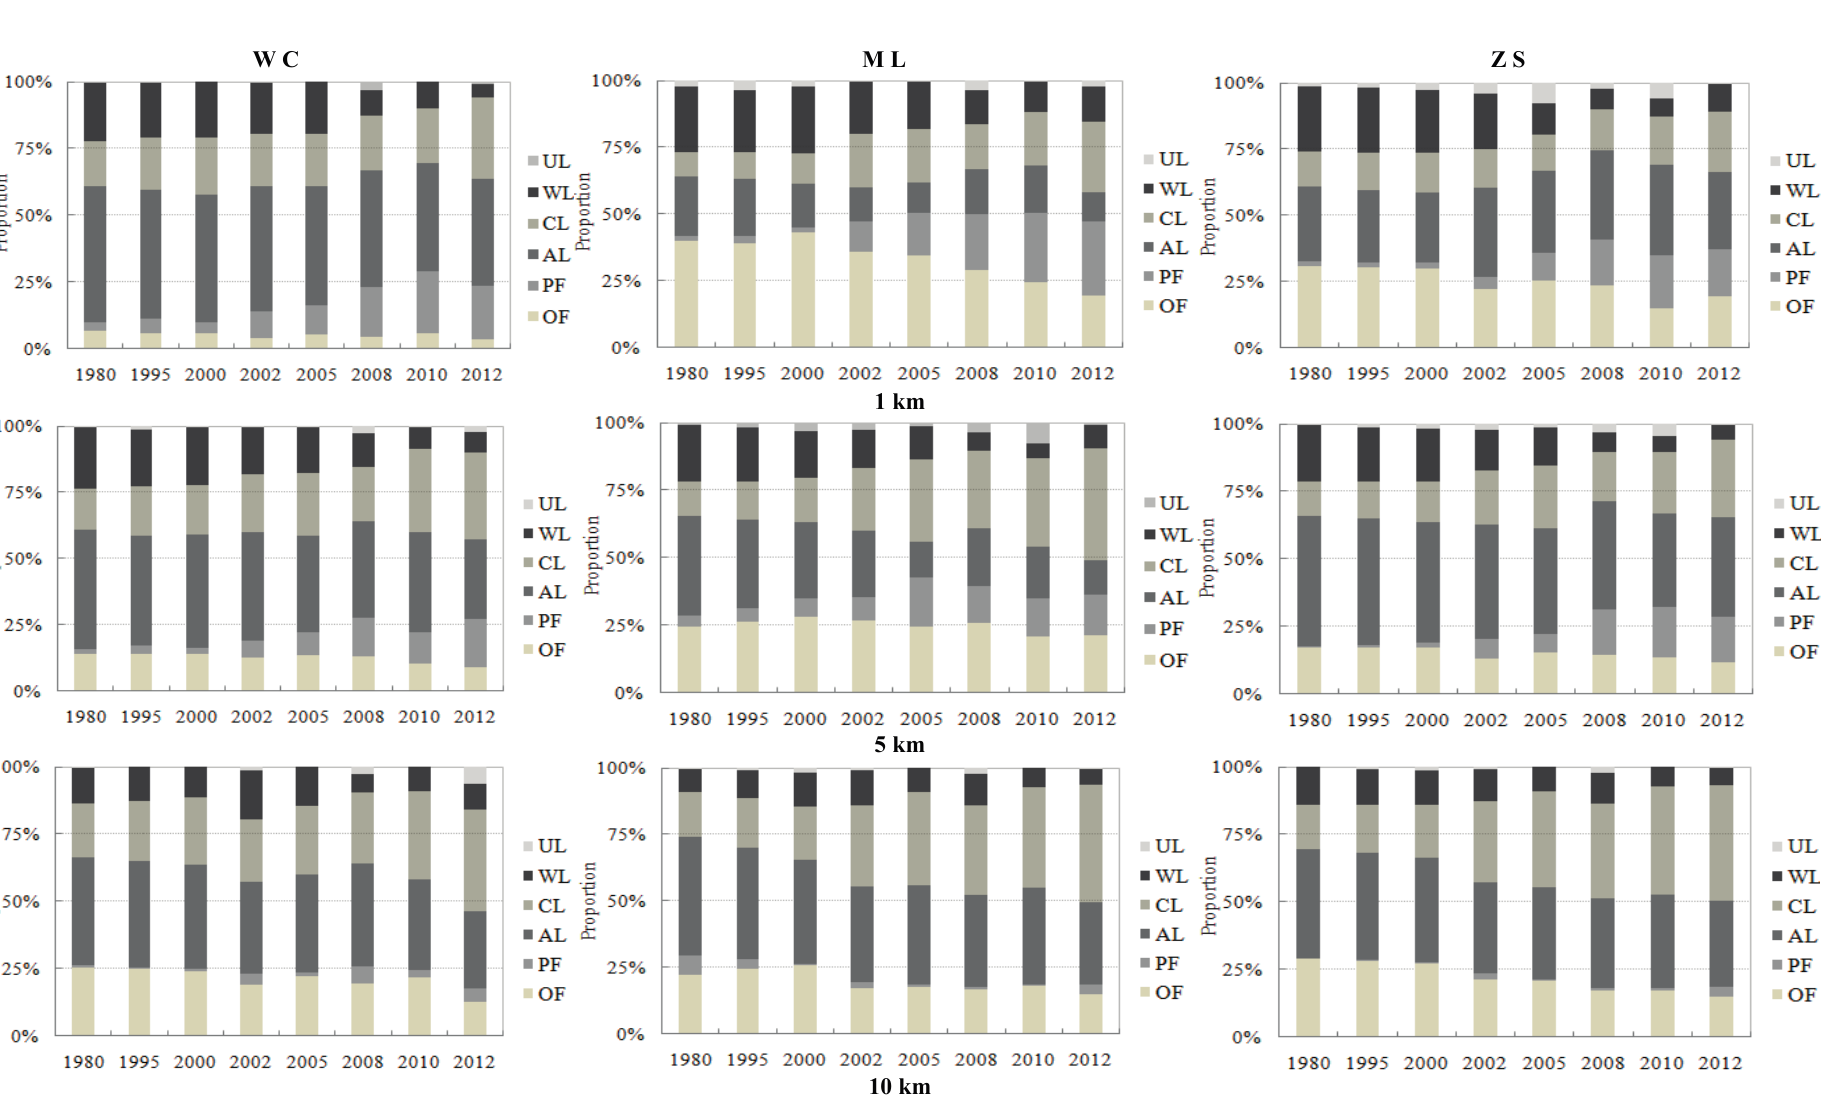
Figure 3. Proportions change tendency of different land use type classified by various buffer distances for three lake